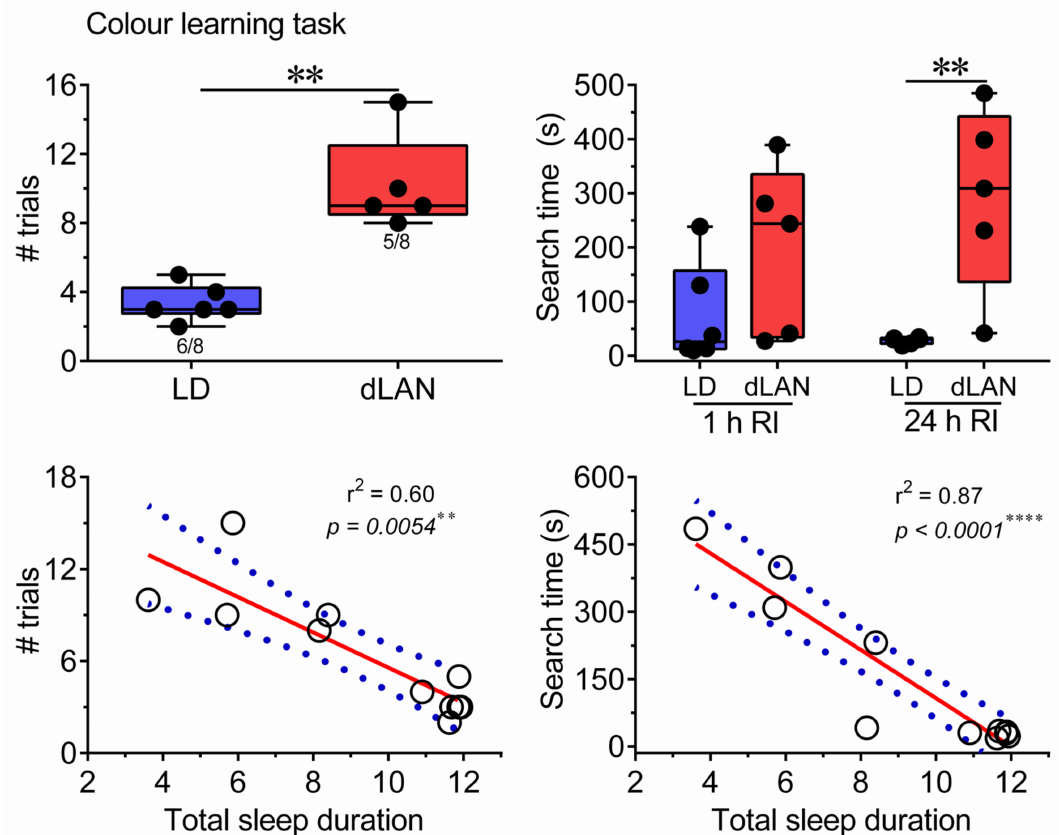
Figure 4. The colour learning and memory performance of adult male zebra finches ( Taeniopygia guttata ) under 12 h light: 12 h darkness (12L:12D), and 12 h light: 12 h dim light at night (12L:12dLAN) as described in Figure 1. We analyzed number of trials to learn the task and search time during 1-h and 24-h memory retention test under LD and dLAN represented in box-whisker plot. Black circle represents individual value. Relationship between number of trials and search time with total sleep duration. The * symbol shows significance tested by Student’s t -test (number of trials), 2-way RM-ANOVA (search time) and correlation between colour learning and sleep. Alpha was set at 0.05 (** p < 0.01, **** p <